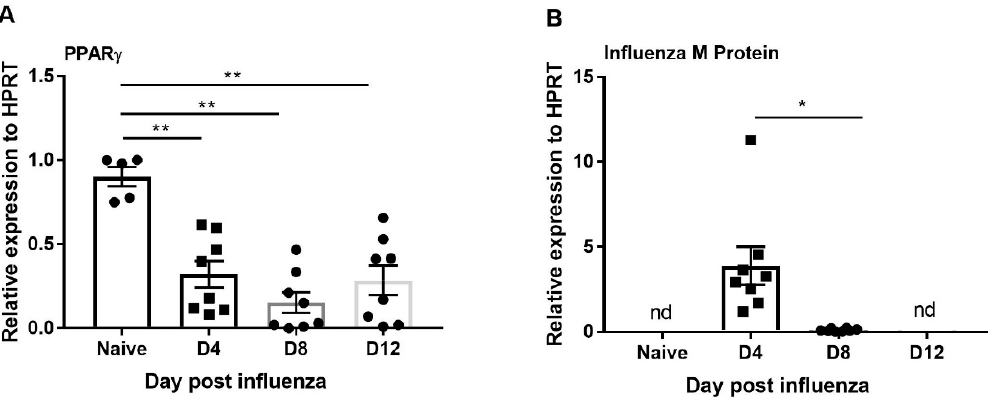
Figure 2. PPAR γ expression is suppressed during influenza infection. WT mice were infected with influenza (100 pfu) and harvested from 0, 4, 8, and 12 days post-infection, and ( A ) PPAR γ expression and B ) influenza M protein expression was measured by RT-PCR. N = 5–8 per group. Data are represented as mean ± SEM, two tailed Student’s t test, * p < 0.05, ** p < 0.001.